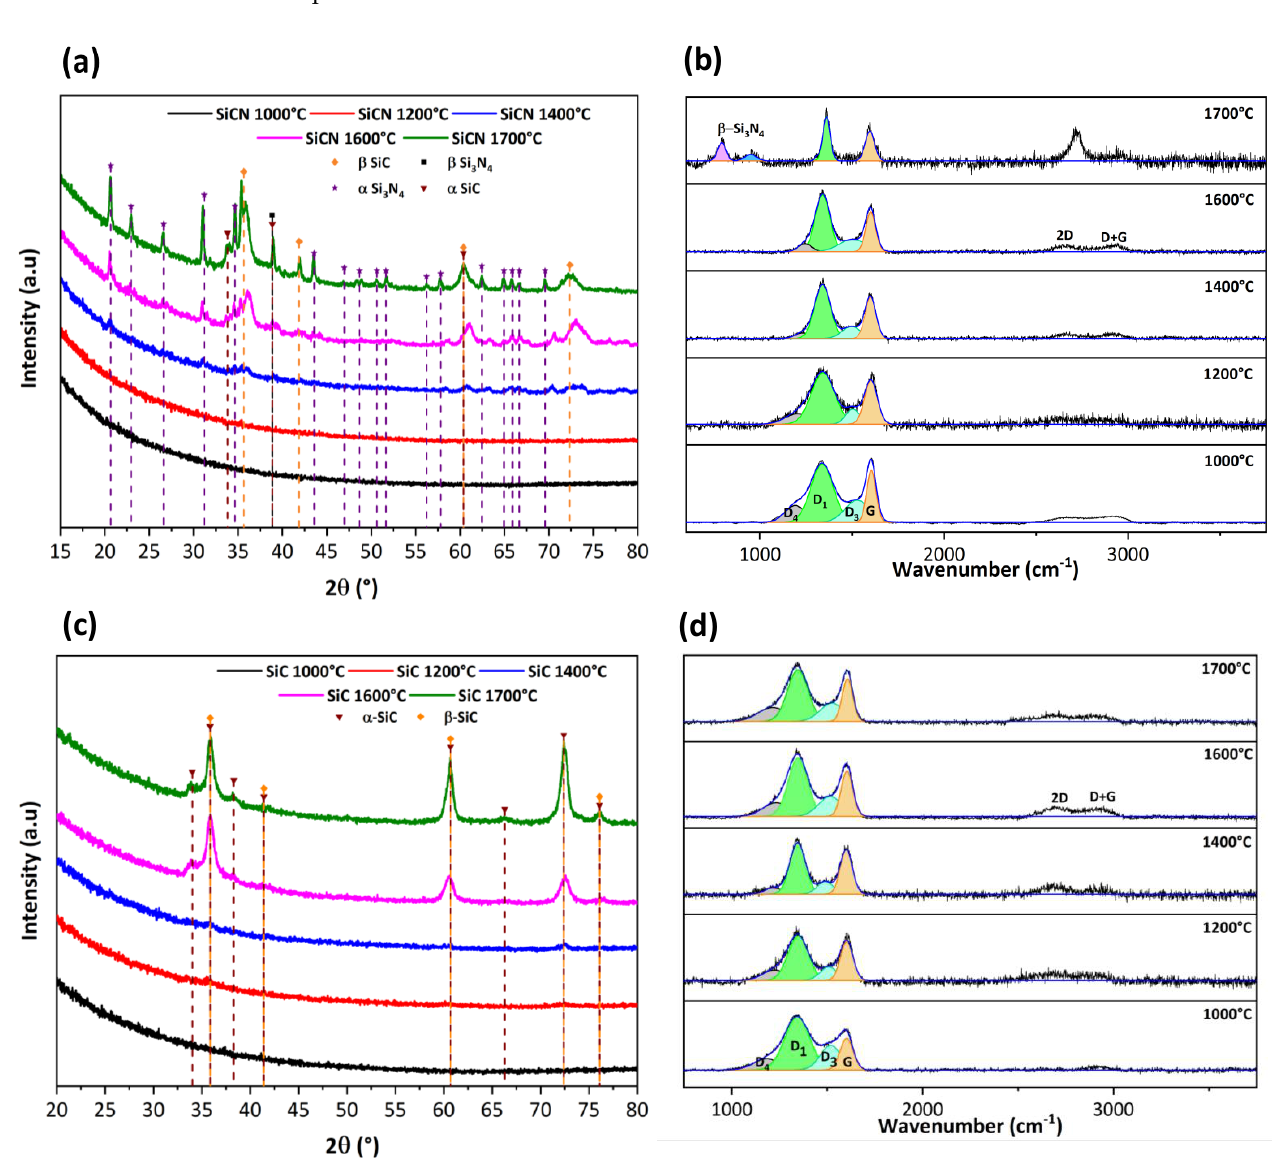
Figure 6. ( a ) XRD patterns of 3D SiCN. ( b ) Raman spectra of 3D SiCN. ( c ) XRD patterns of 3D SiC. ( d ) Raman spectrum of 3D SiC with temperatures ranging between 1000 and 1700 °C under inert atmosphere. Table 3. Position, FWHM and Id/Ig for SiCN and SiC 3D ceramics.